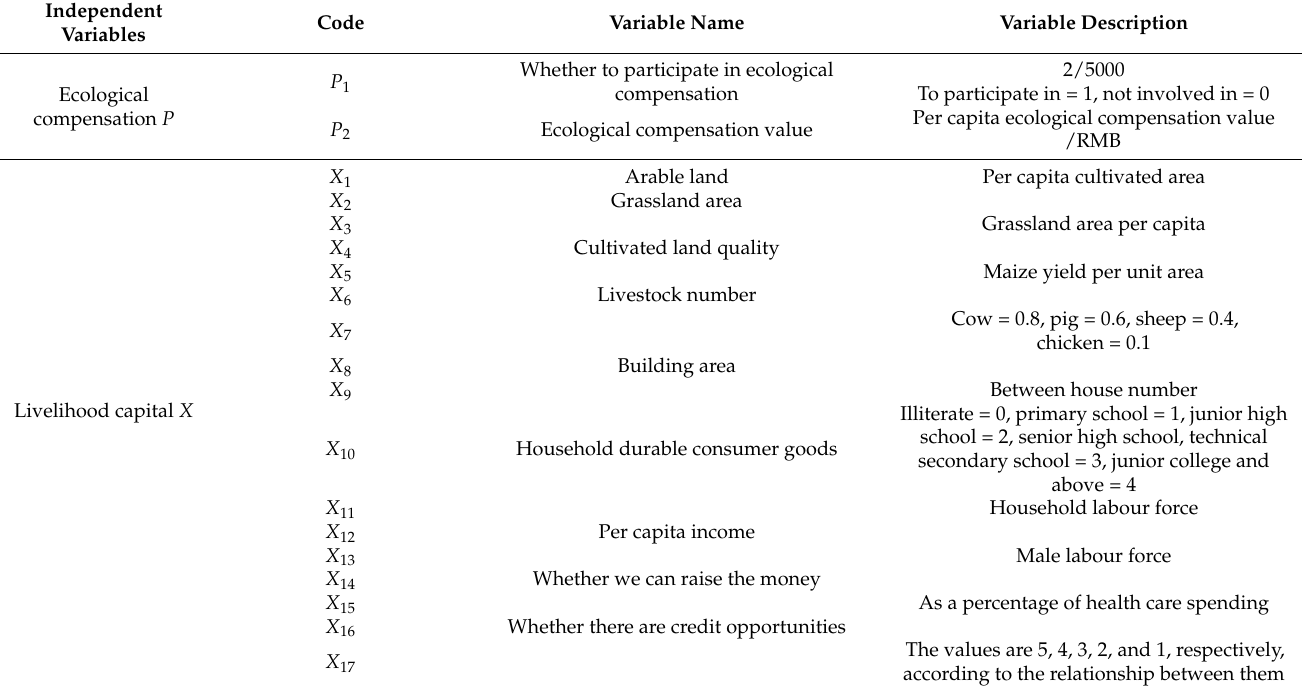
Table 2. Independent variables used in the models and their